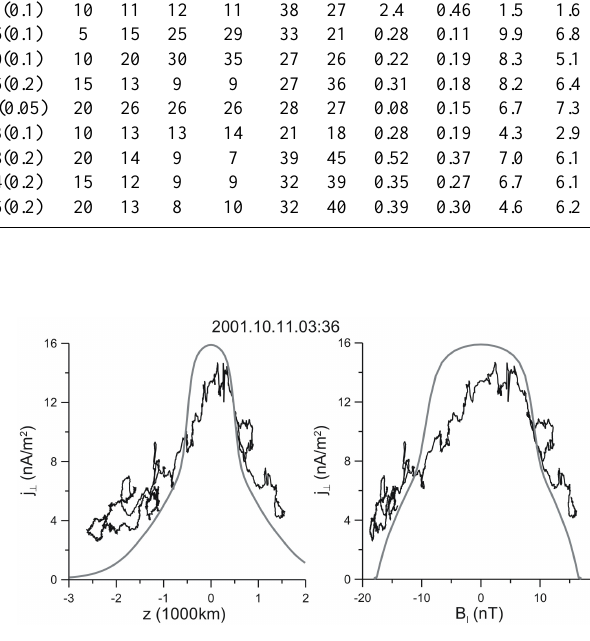
Fig. 5. Comparison of experimental (black) and model (grey) cur- rent density profiles w.r.t. coordinate along the normal and magnetic field component B l . Case 11 October 2001